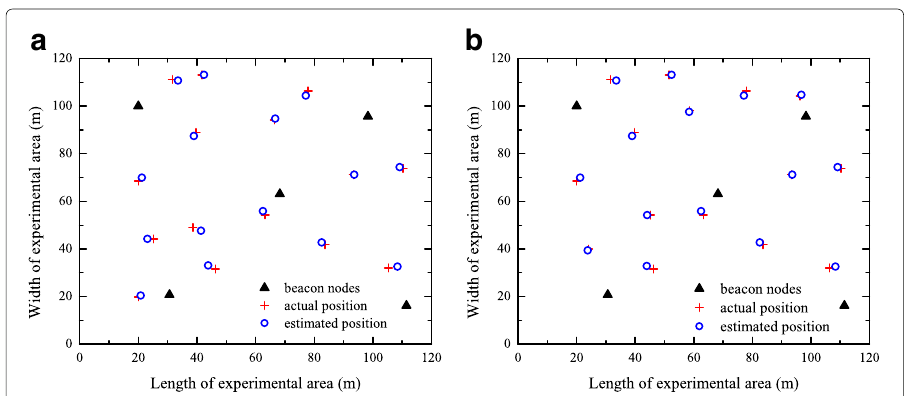
Fig. 10 Position estimation results at different iteration times. a The number of iterations is 1. b The number of iterations is